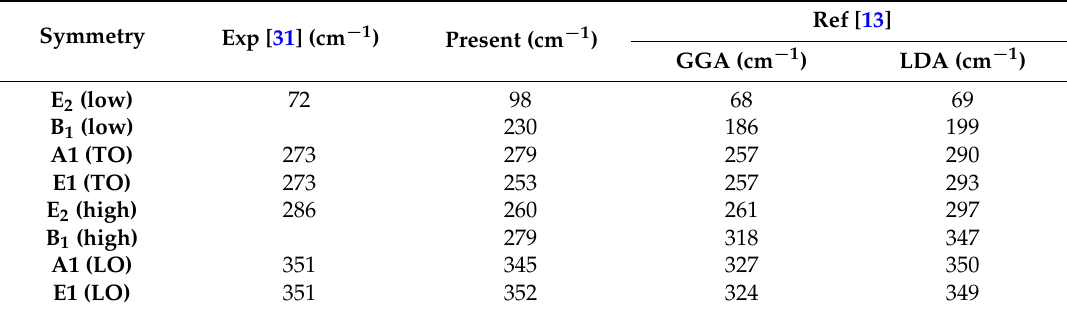
Table 3. Comparing our results with previous experimental and theoretical data for the phonon frequencies (cm − 1 ) of WZ ZnS under zero pressure and temperature.